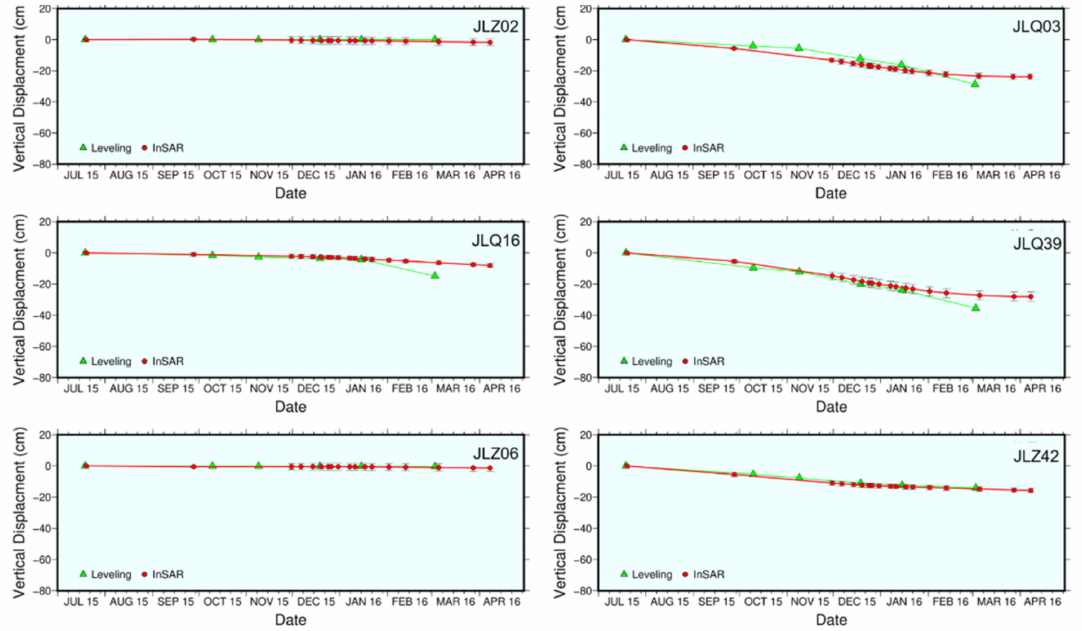
Figure 15. Comparison of time-series subsidence between leveling data and MSBAS results at the selected points of the Jiulong